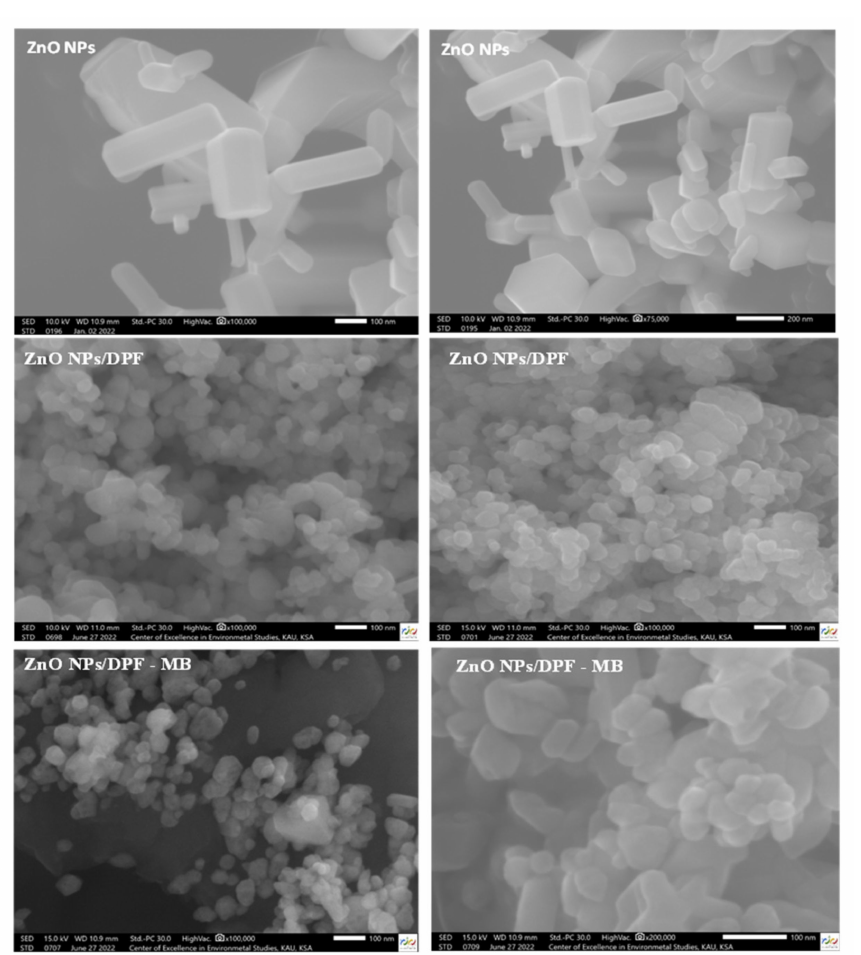
Figure 2. FE–SEM images of ZnO NPs, ZnO NP/DPF, and ZnO NP/DPF at different